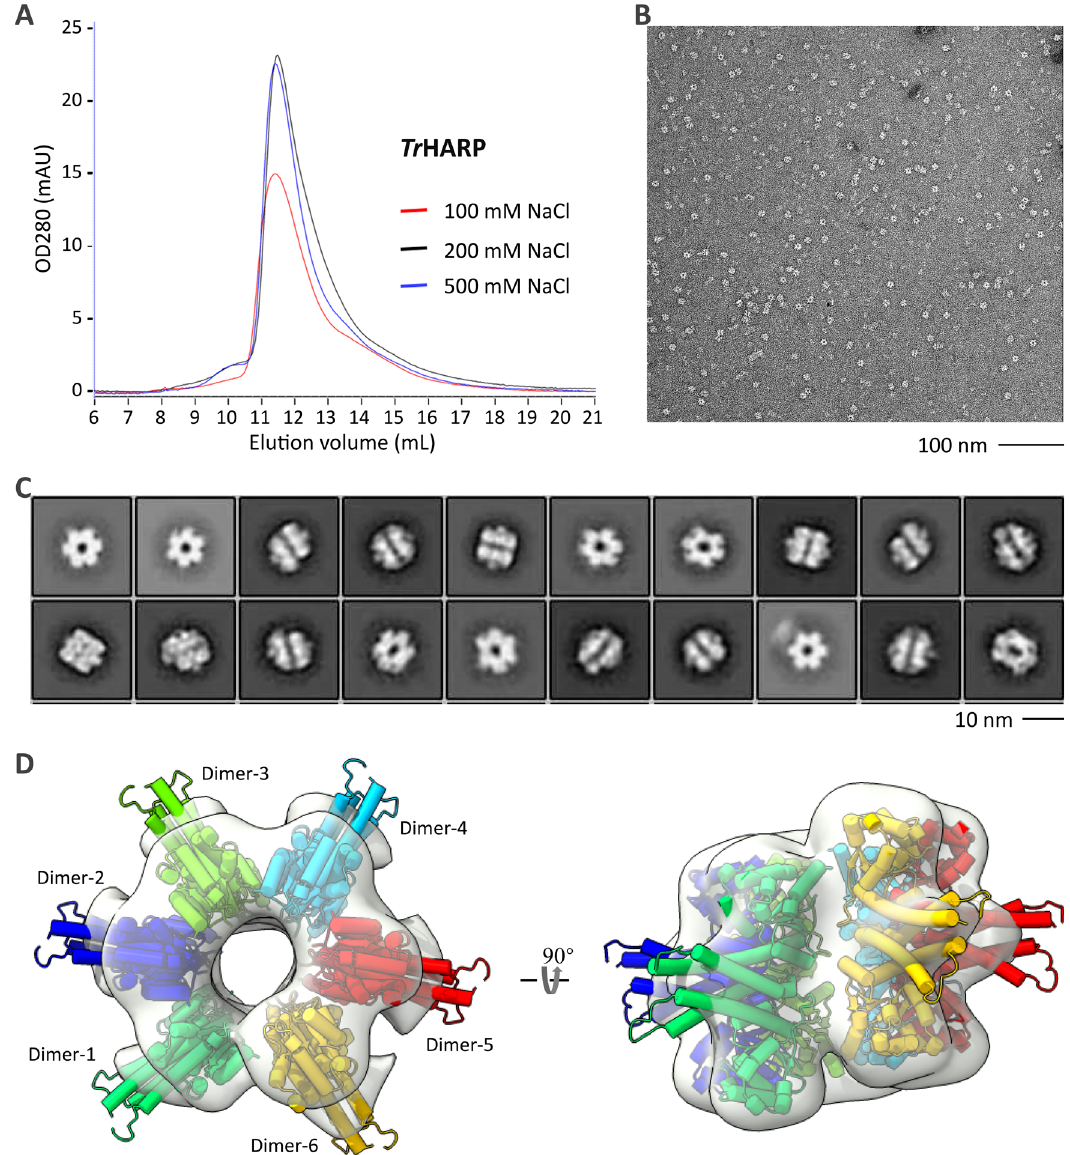
Fig. 6 Electron microscopy analysis of Tr HARP. A Size-exclusion chromatographic analysis of Tr HARP. Source data are provided in Source Data fi le. B A typical negative stain CCD image of Tr HARP. Experiments were repeated independently twice with similar results. C The reference-free two-dimensional class averages of Tr HARP. D The electron microscopy density maps of Tr HARP, fi tted with Pb HARP